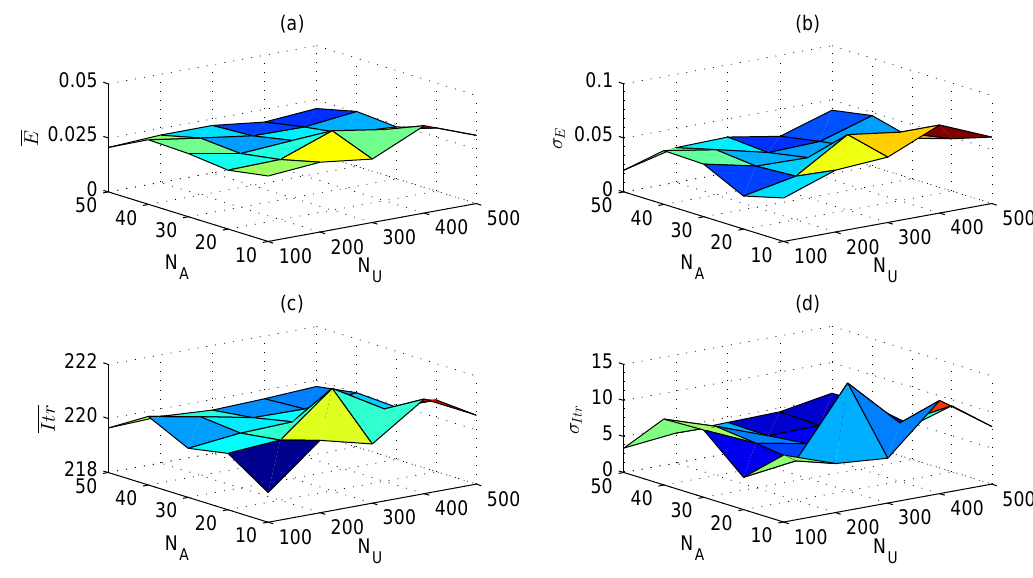
Figure 5. Impacts of N U and N A on the localization performance of CPSO. ( a ) E ; ( b ) σ E ; ( c ) Itr ; ( d ) σ Itr .